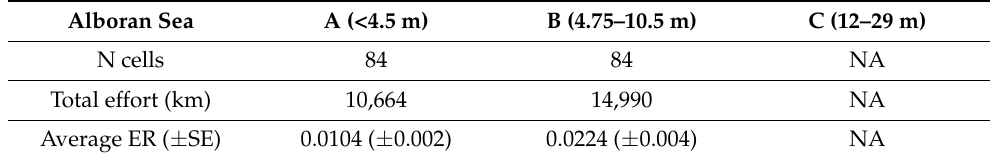
Table 3. The striped dolphin ER obtained by category A (dedicated vessels with height <4.5 m) and B (dedicated vessels with height between 4.75 and 10.5 m) in subzone M1 (Alboran Sea). The ER obtained by category B is about double that of category A. Alboran Sea A (<4.5 m) B (4.75–10.5 m) C (12–29 m) N cells 84 84 NA Total effort (km) 10,664 14,990 NA Average ER ( ± SE) 0.0104 ( ± 0.002) 0.0224 ( ±